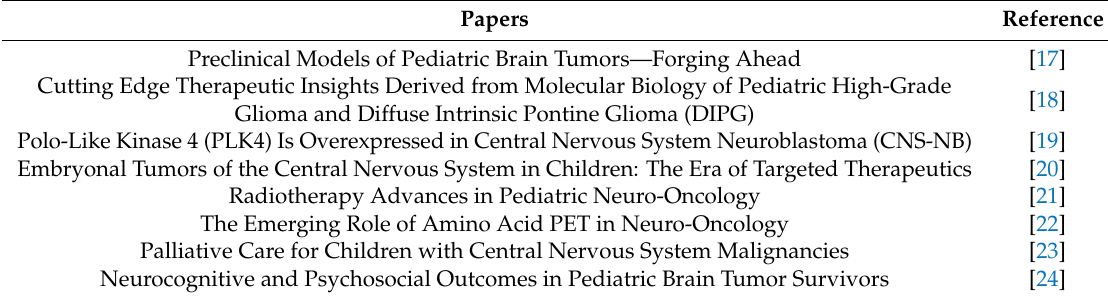
Table 1. Published papers in Special Issue Update in Pediatric